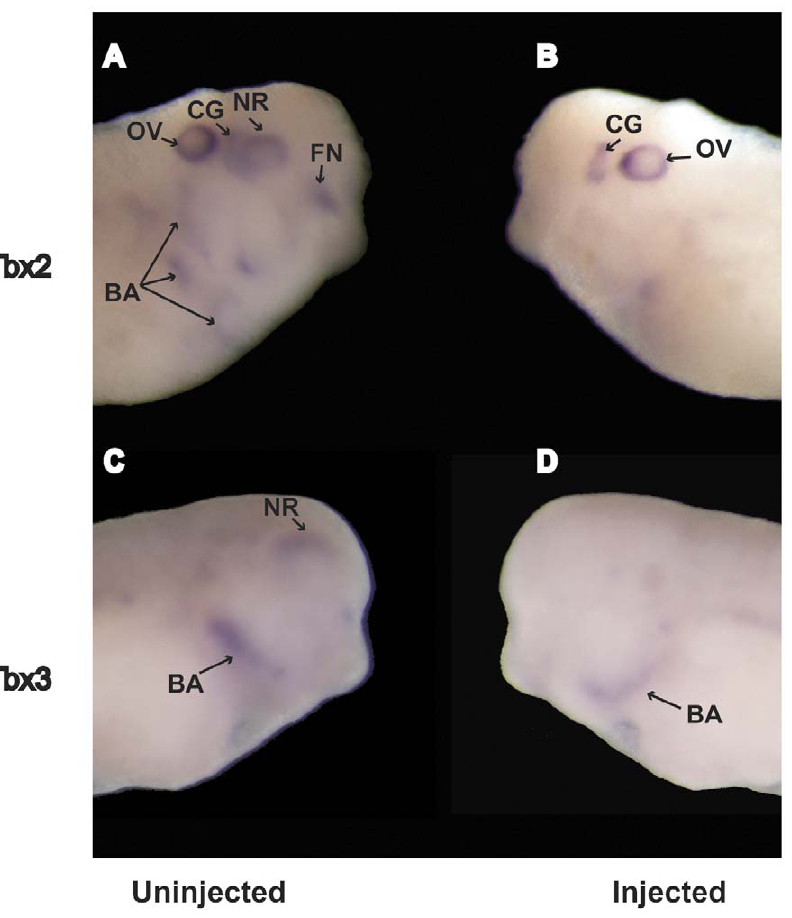
Figure 7. BMP target genes Tbx2 and Tbx3 . Whole mount hybridization in situ of BMP target genes Tbx2 and Tbx3 in stage 33/34 embryos injected unilaterally with 90 ng SPC7 morpholino. Injected sides are shown to the right. (A, B) Lateral view of embryos showing Tbx2 expression was lost in the eye on the MO-injected side only (NR, neural retina; CG, cranial ganglion; OV, otic vesicle; BA, branchial arches; FN, frontonasal process). (C, D) Lateral view of stage 33/34 embryos showing a similar result for